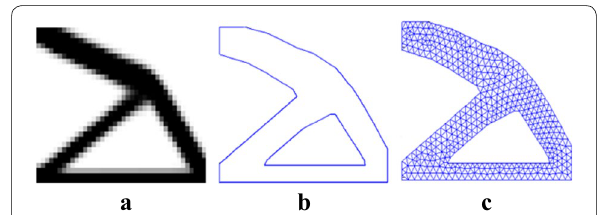
Figure 2 Illustration of two different mapping methods: a RDM method; b LRDM